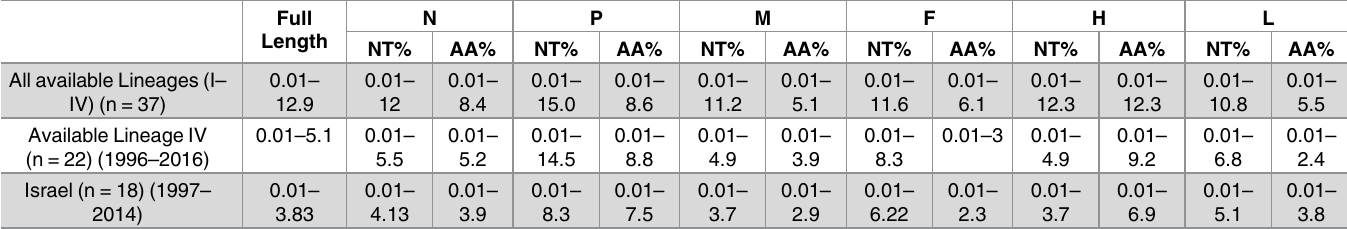
genomes excluding vaccine viruses (n = 37) and those sequenced in this study (n = 18), and Table 2. Nucleotide and amino acid percentage differences between PPRV